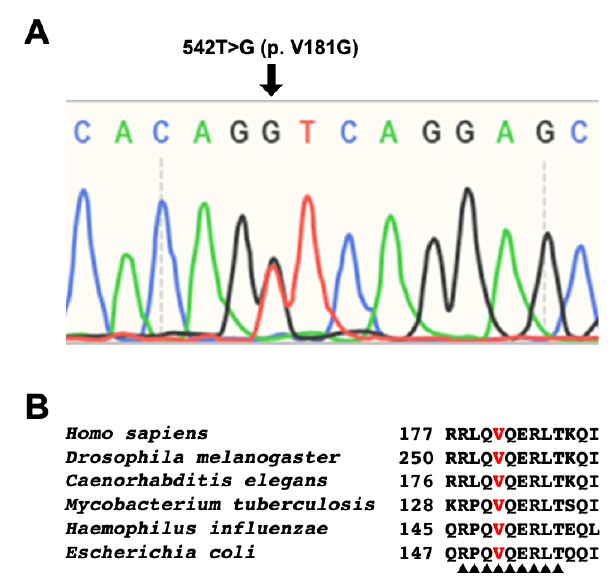
Figure 2. A : Sanger sequencing chromatogram which shows a novel heterozygous mutation c. 542T>G (p. Val181Gly) in the first amino acid of exon 5 in the GCH1 gene ( black arrow ). B : Amino acid sequence alignment of the GCH1. Note that the first Val in exon 5 (highlighted in red ) is highly conserved across species. Residues involved in catalysis are highlighted with black triangles